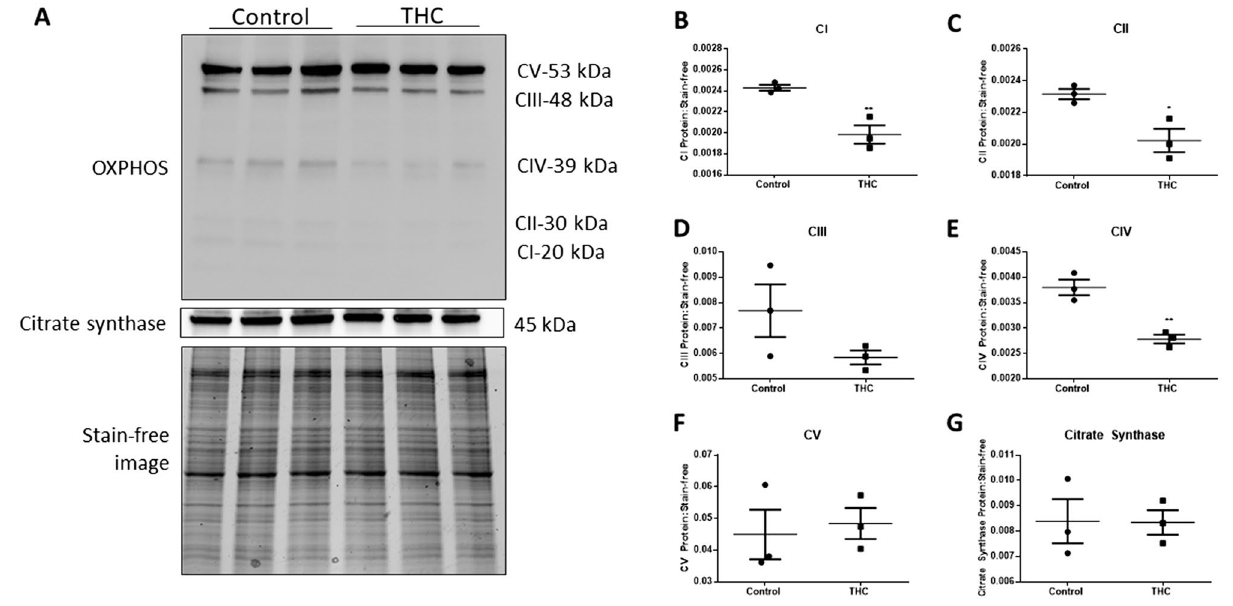
Figure 7. THC reduces levels of mitochondrial complex proteins without altering citrate synthase protein expression. (A) Western blot images (20 µg) of mitochondrial OXPHOS respiratory complex protein levels, citrate synthase and stain-free image in control and 20 µM THC-treated conditions after 48 h. A cocktail antibody comprising the following subunits of respiratory complex proteins was used: NADH dehydrogenase (ubiquinone) 1 beta subcomplex 8 (NDUFB8; complex I), succinate dehydrogenase complex, subunit B (SDHB; complex II), ubiquinol-cytochrome c reductase core protein II (UQCR2; complex III), cytochrome c oxidase subunit 2 (COXII; complex IV) and ATP synthase 5A (ATP 5A, Complex V). Quantification of the levels of each of the above-mentioned subunits and CS expression are shown, respectively (B–G) The individual points represent the ratios of proteins normalized to stain-free image (n = 3), the horizontal lines represent the means and the error bars represent SEM. Significant differences were determined by Student’s t-test. ** P < 0.01 (B,E) ; * P < 0.05 (C) ; P = ns (D,F,G)